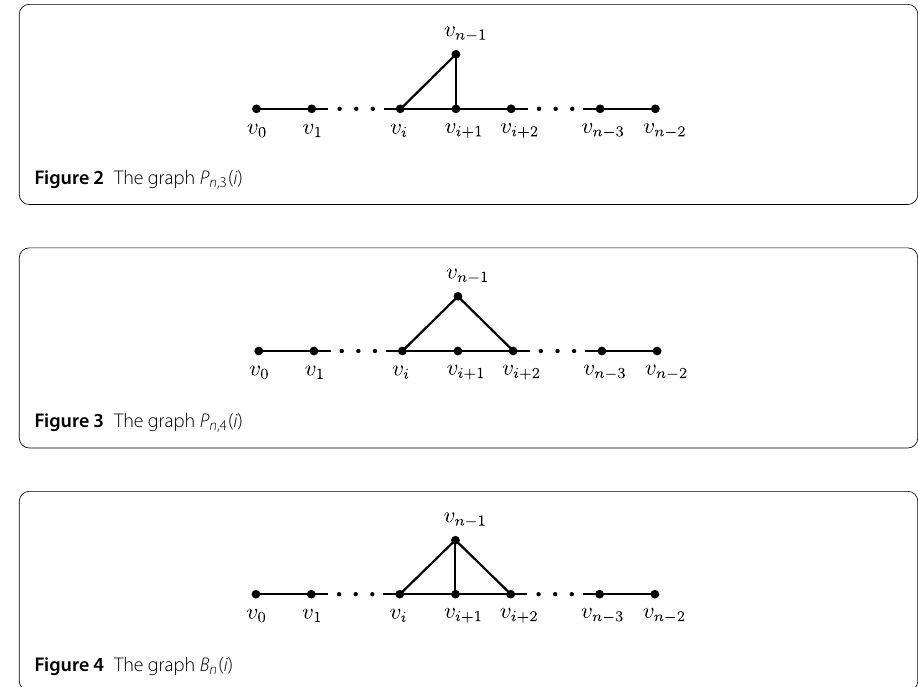
Figure 4 The graph B n ( i